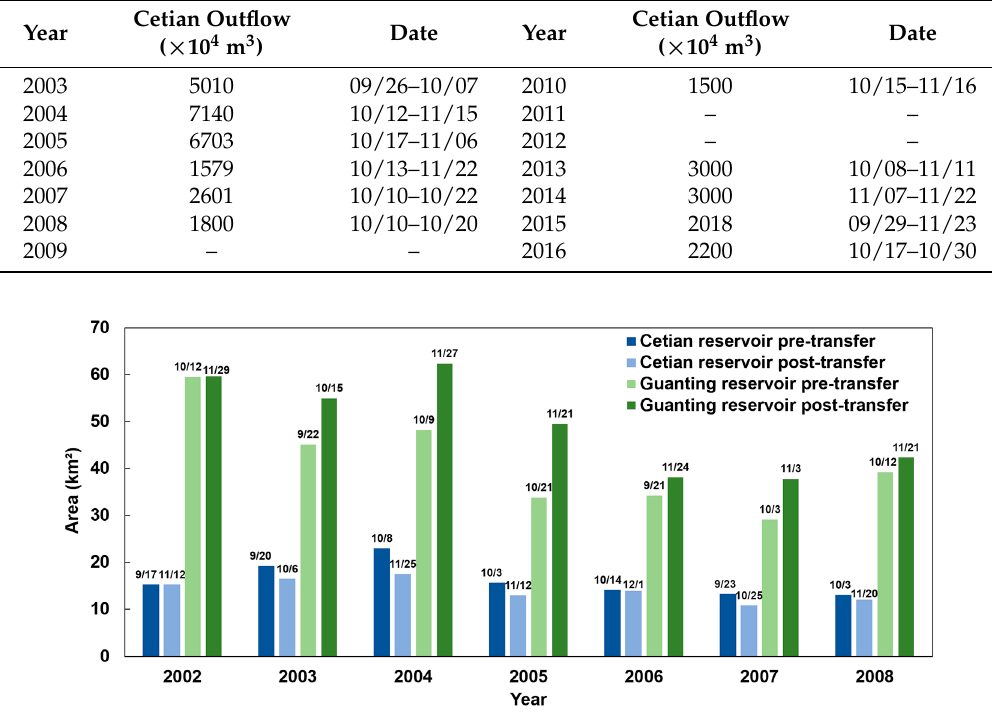
Figure 10. Reservoir water extents extracted from Landsat-series imagery acquired before and after water delivery. The dates of the image acquisition are listed above the